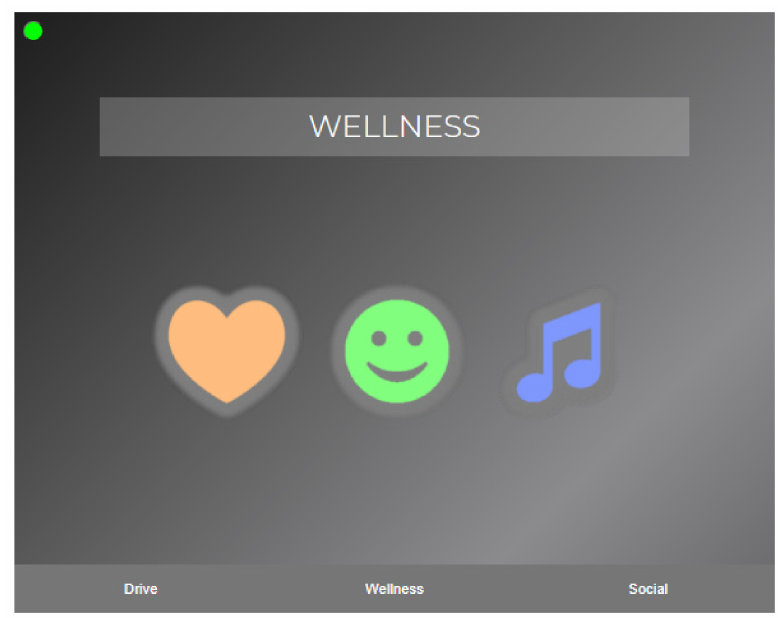
Figure 4. The Wellness panel . Warm colors ( red for maximum) express a high pulse, a nervous expression, and an energic playlist, while cool colors ( blue for minimum) express a lower pulse, a tired expression (yawning or blinking at a high rate or too slow as time interval measured between closing and reopening the eye), and a slow playlist. A green pulse and a green emoji represent the optimal state. The pulse is constantly updated, while the tempo is updated once a new soundtrack is